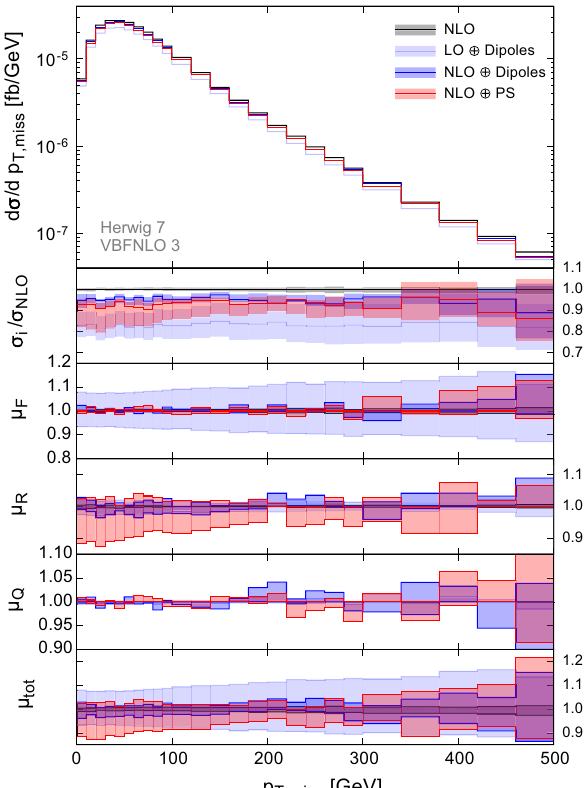
Fig. 5 SameasFig.3,showingthe p ⊥ spectrumoftheleadingcharged lepton.Thespectrumofthesubleadingleptonshowsasimilarbehaviour ization ( μ R ) and hard veto scale ( μ Q ), and all of them ( μ tot ). ; 2 ] . For Variations are performed in the range μ i /μ 0 ∈ [ 1 2 the total uncertainty envelope, we allow the individual scales to vary independently, but require that ratios of scales also ; 2 ] fulfill the condition μ i /μ j ∈ [ 1 2